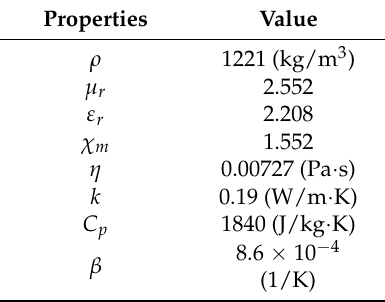
Table 2. Physical properties of the working fluid